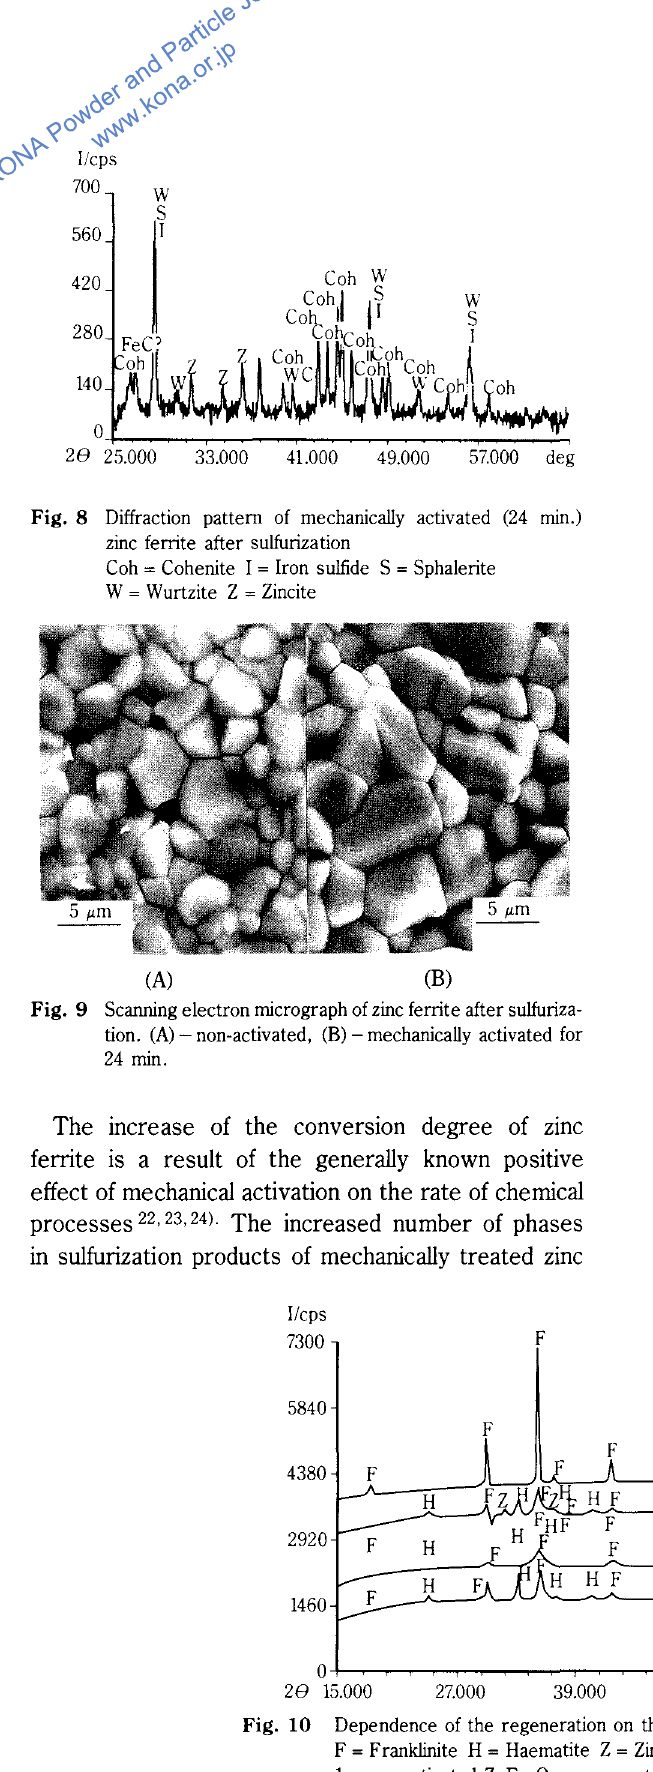
Fig. 10 Dependence of the regeneration on the primary mechanical activation F = Franklinite H = Haematite Z =